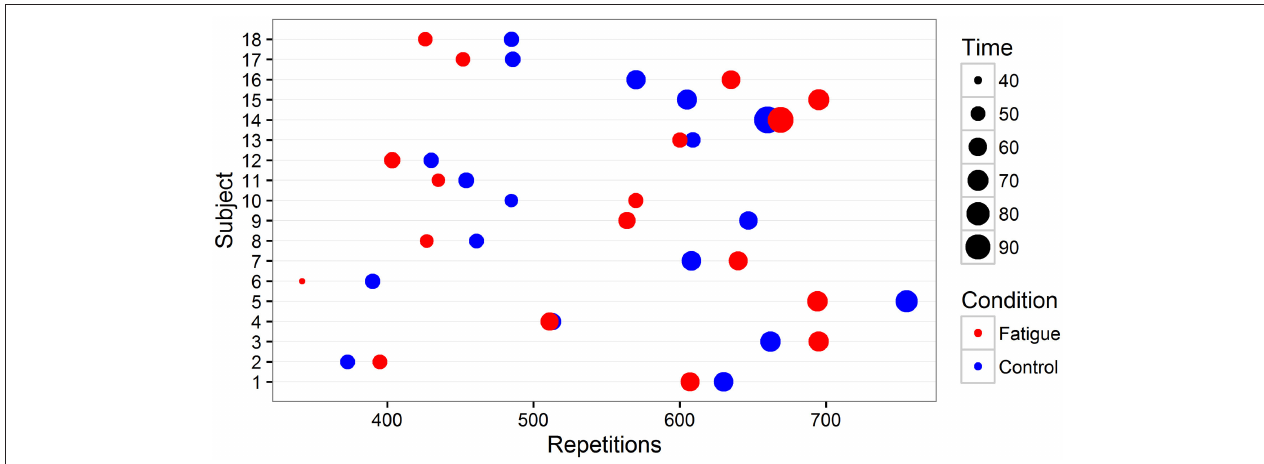
FIGURE 4 | Individual performance and task execution. Each participant ( n = 18) is displayed on the y-axis. Percent time-on-task is visually expressed as magnitude of icons. Position of fatigue and control icons on the x-axis correspond to repetitions completed as a function of intervention.